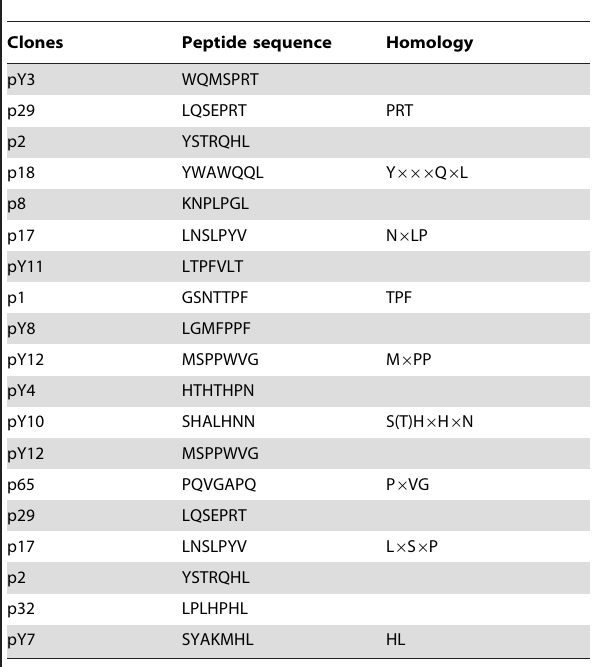
Table 1. Isolated peptides that bind to A b -4-8 by phage display.